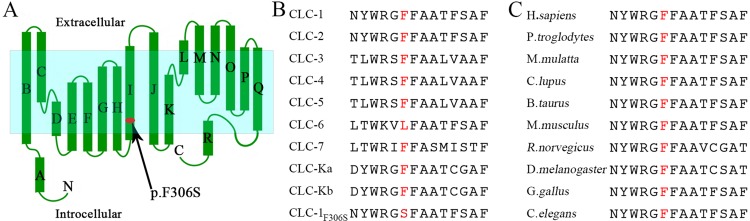
Schematic of CLC-1 channel and multiple sequence alignment.(A) The localization of p.F306S mutation on the CLC-1 channel. (B) The Phe306 amino acid residue is conserved in every member of the CLC family in humans except for CLC-6. (C) The Phe306 amino acid residue is conserved from C. elegans to H. sapiens.